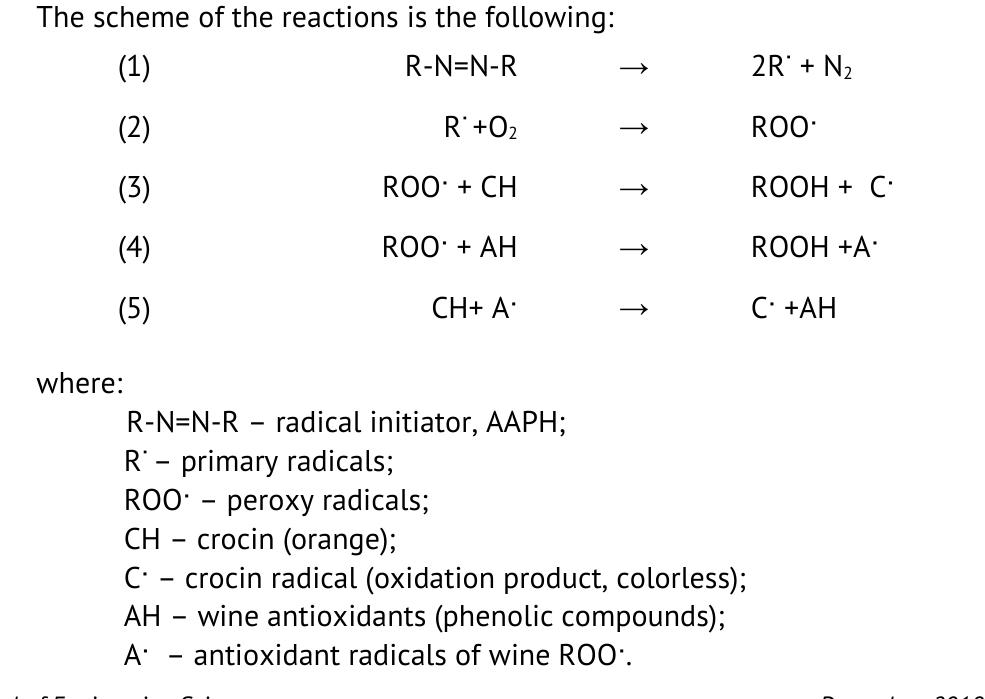
Figure 6. The effect of increasing doses of bentonite on total polyphenol index (IPT) and on the main groups of phenolic compounds in the Viorica, Chardonnay and Sauvignon